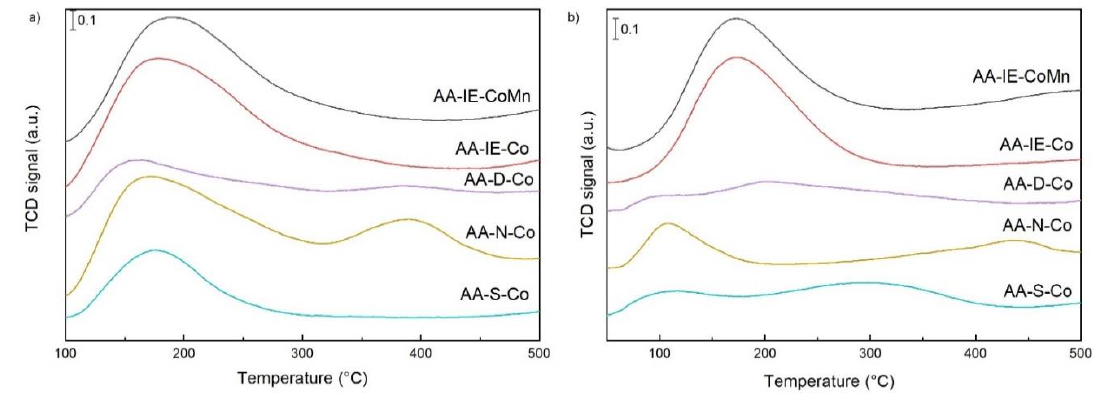
* P = population of the relevant sites, index 1–first deconvolution peak, 2–second deconvolution peak and 3–third deconvolution peak.